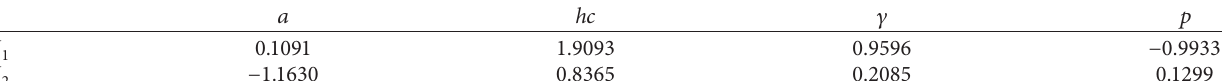
Table 7: The skewness and kurtosis of the fitted parameters.